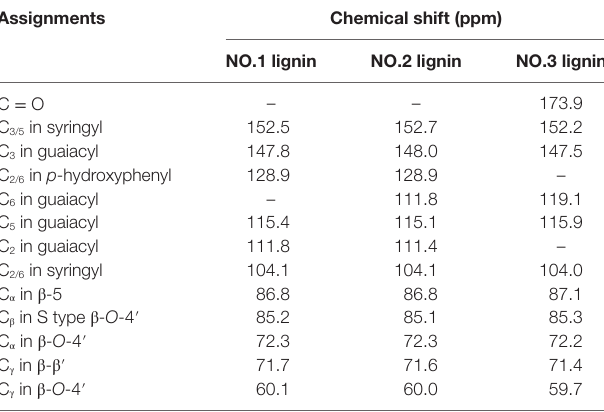
Table 3 | Signal assignments for the 13 C-NMR spectra of three lignin samples from dilute acid pretreated switchgrass.